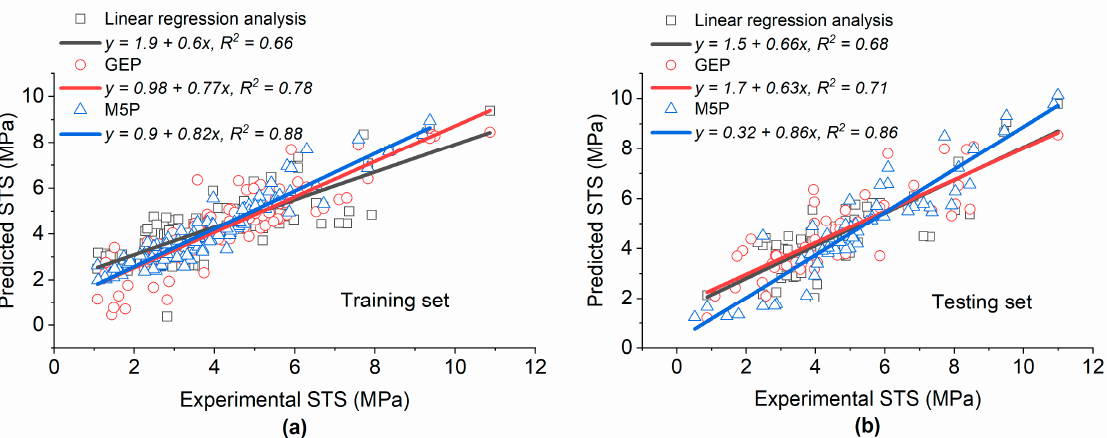
Figure 8. Actual and predicted values of STS: ( a ) training set; ( b ) testing set.